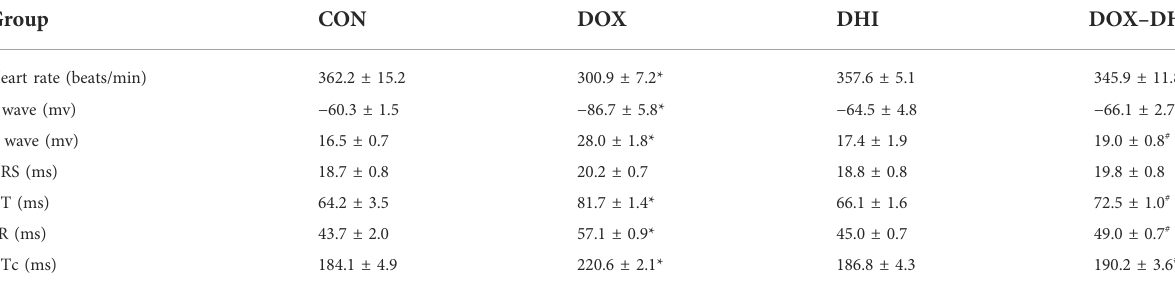
TABLE 2 ECG parameters of rats treated with DHI and/or